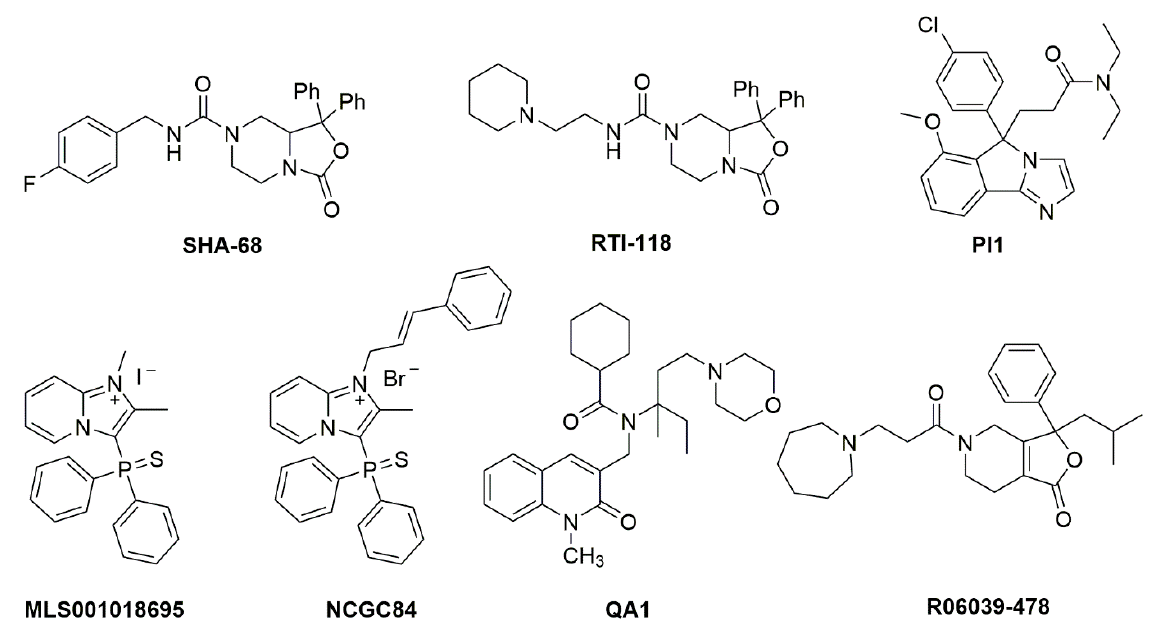
Figure 2. Chemical structures of NPSR1 antagonists. Details about synthesis and pharmacological activities can be found in the original literature. SHA 68 [18], RTI-118 [68], PI1 [118], MLS001018695 [119], NCGC84 [23], QA1 [120], R06039-478 [121].